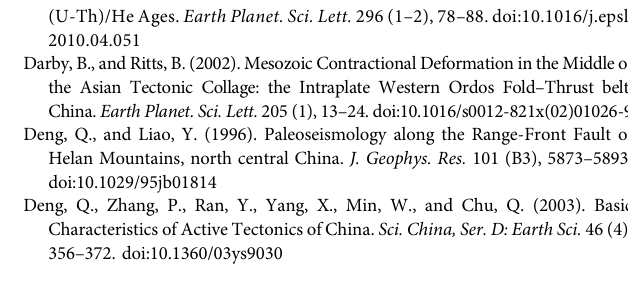
Frontiers in Earth Science |